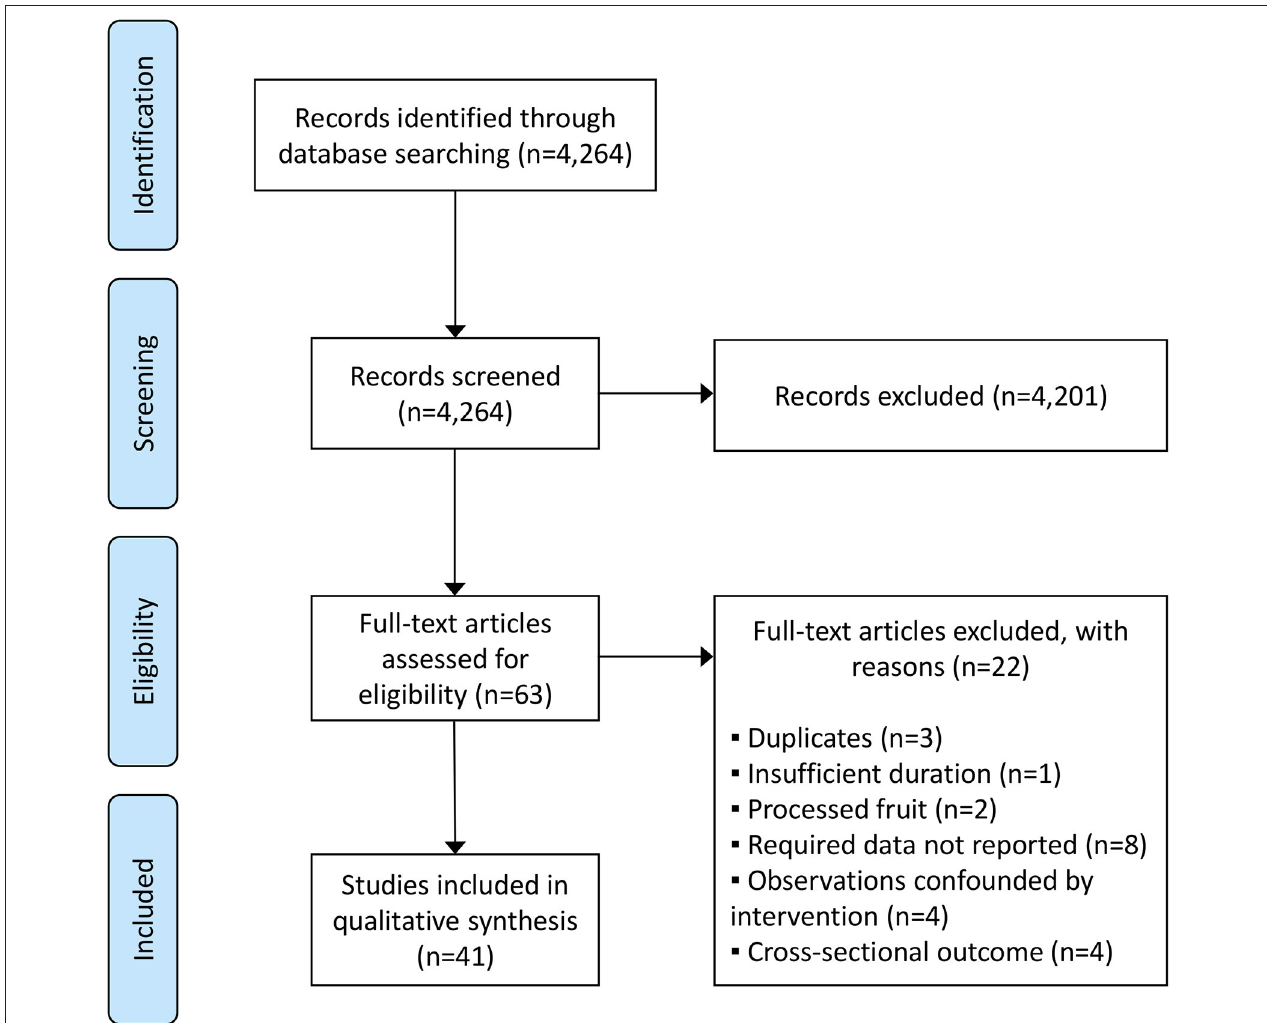
FIGURE 1 | PRISMA flow diagram summarizing the study identification and selection process.